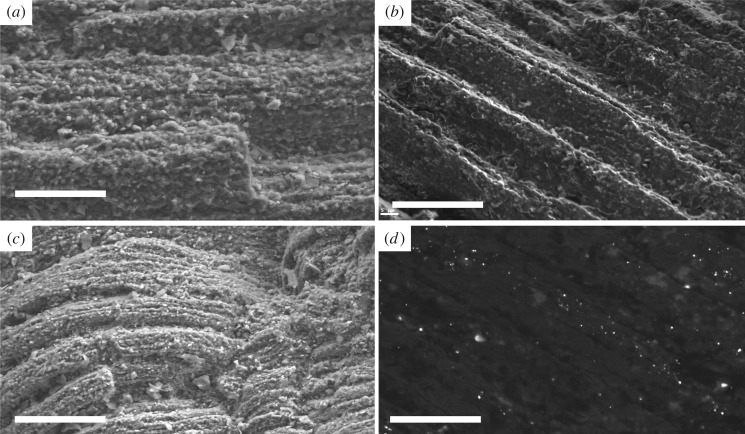
SEM, BSE and SEM-CL images of the silicified muscle tissue. (a) BSE image shows silicified muscle tissue. Scale bar, 20 µm (MGUH 31568). (b) SEM image of muscle tissue shows fibrous nature and small spherical nodules of silica. Scale bar, 20 µm (MGUH 31570). (c) BSE image showing truncated silicified muscle tissue. Scale bar, 20 µm (MGUH 31571). (d) SEM-CL image showing low monotone grey luminosity of the silica in the muscles, indicating similar formation conditions as that found in Buenellus [5] (MGUH 31572).